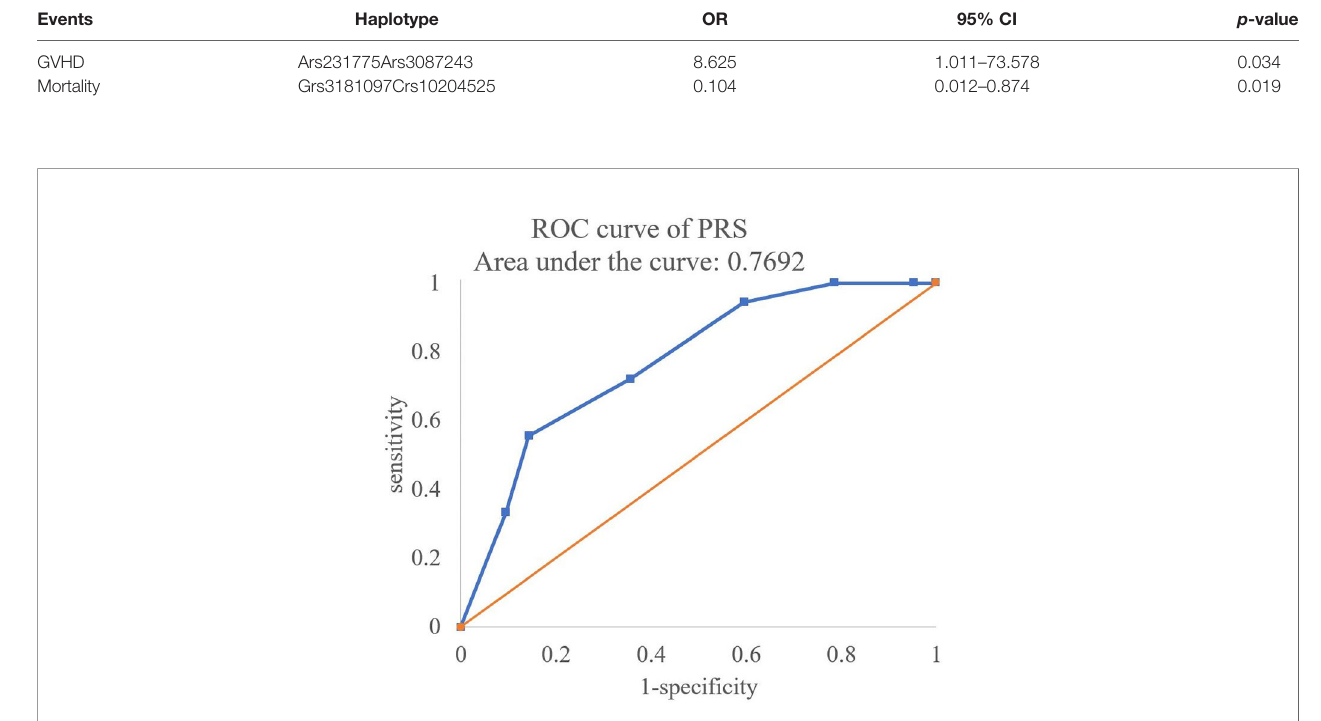
FIGURE 2 | The ROC curve of the PRS for predicting the risk of CBT adverse reactions.